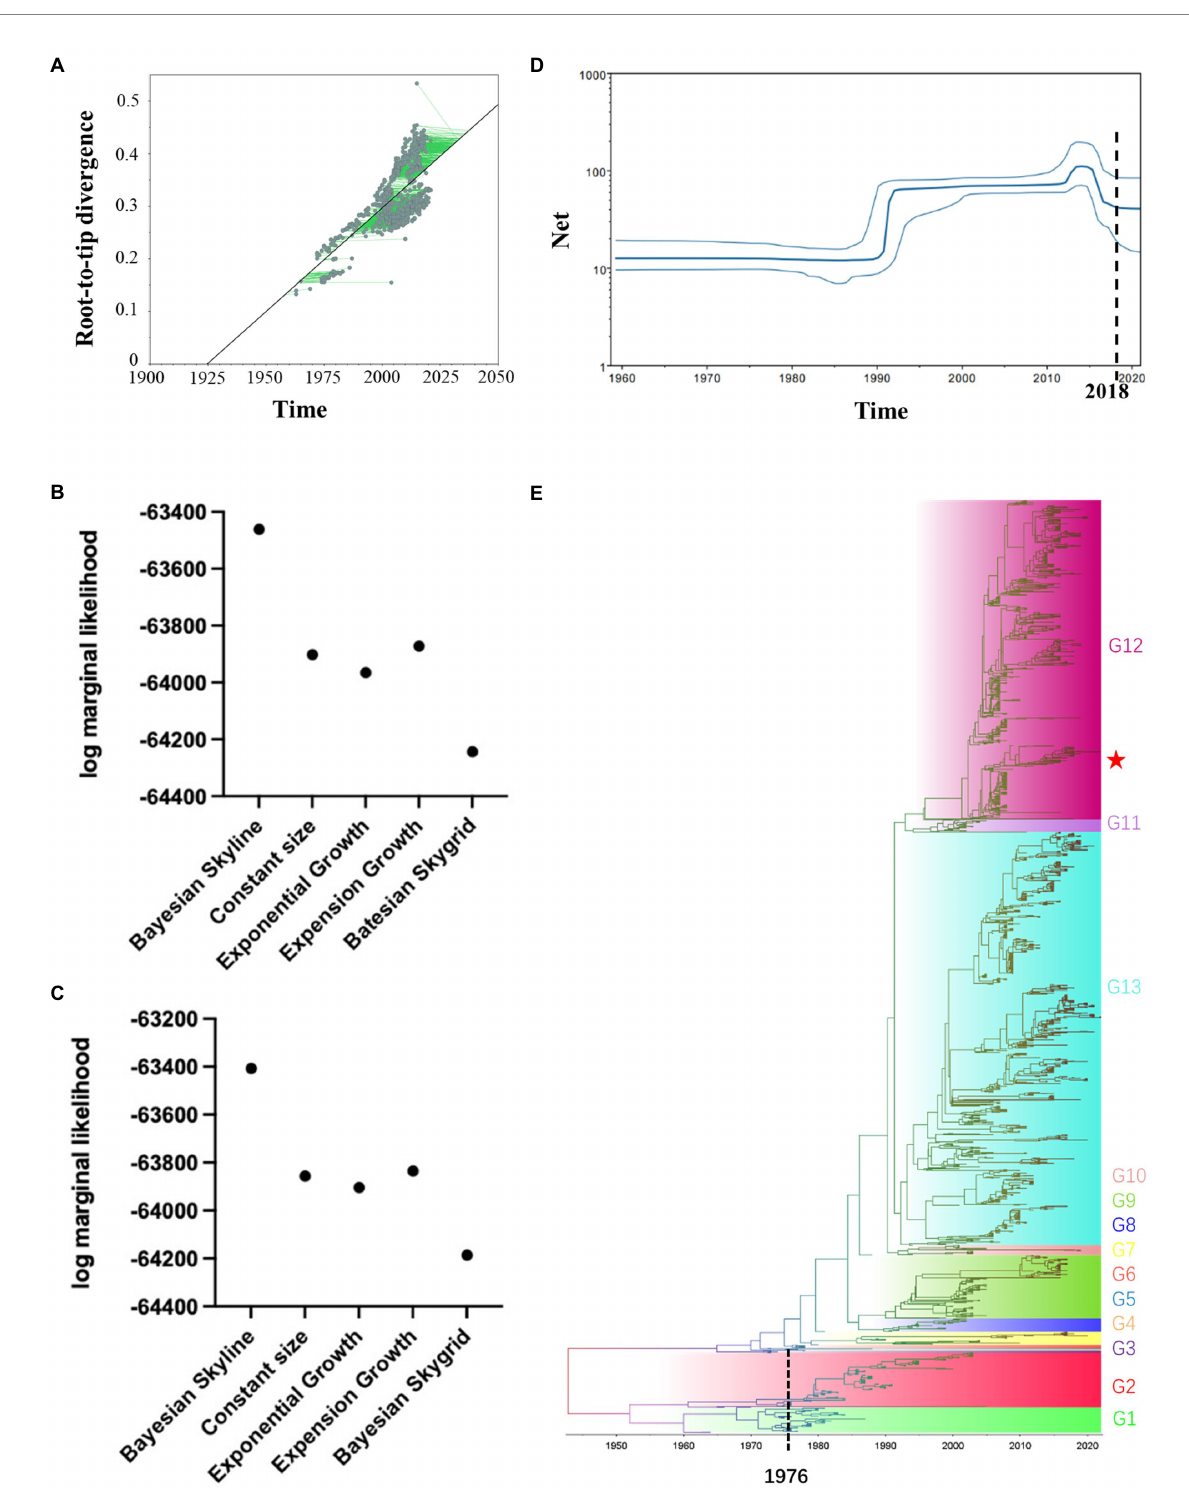
FIGURE 3 Temporal distribution of the H6-subtype influenza virus. (A) Root-to-tip regression analyses. Plots of the root-to-tip genetic distance against sampling time were shown for phylogenies estimated from 2063 HA gene sequences. (B) Stepping-stone estimation approaches were used to assess the best fitting model through marginal likelihood estimation. (C) Path-sampling estimation approaches were used to assess the best fitting model through marginal likelihood estimation. (D) The Bayesian skyline plot was based on the individuals infected by H6NX-subtype AIVs. (E) Maximum clade credibility tree of HA gene. The MCC tree was constructed by BEAST (v2.6.6) with GTR + G distribution nucleotide substitution model, relaxed molecular clock, the tree prior was Coalescent: Bayesian Skyline and 4 × 10 8 total chain length, sample every 1,000